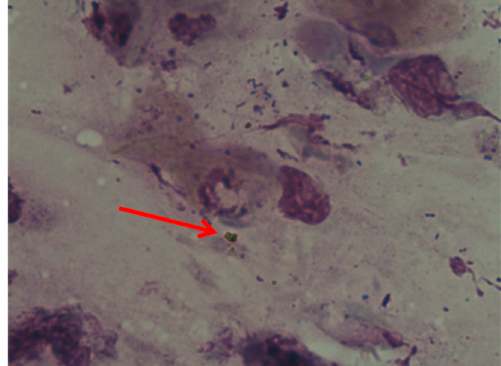
Figure 2. Optical microscope image. The red arrow shows the presence of masses indicating a suspected infection (100 × image enlargement, oil immersion).